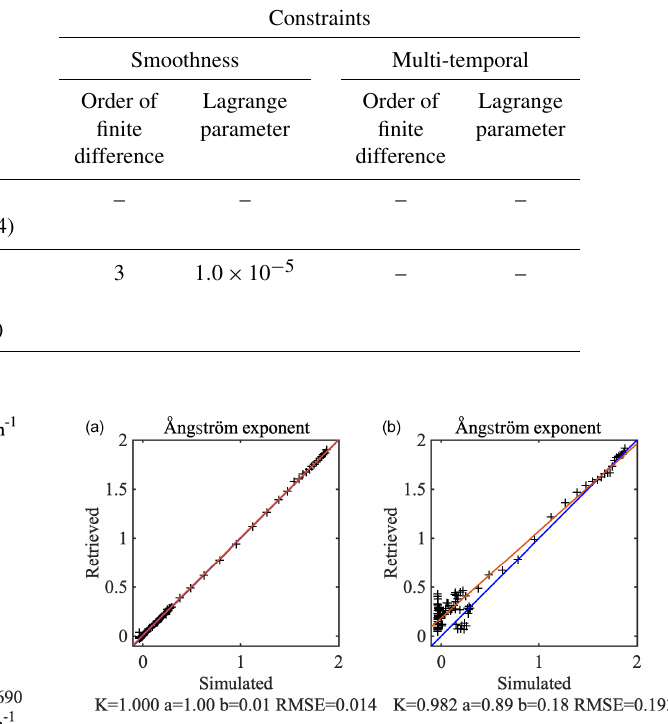
Figure 20. Comparison between simulated and retrieved Ångström exponent profiles at 455 / 940nm in noise-free (a) and noisy (b) con-